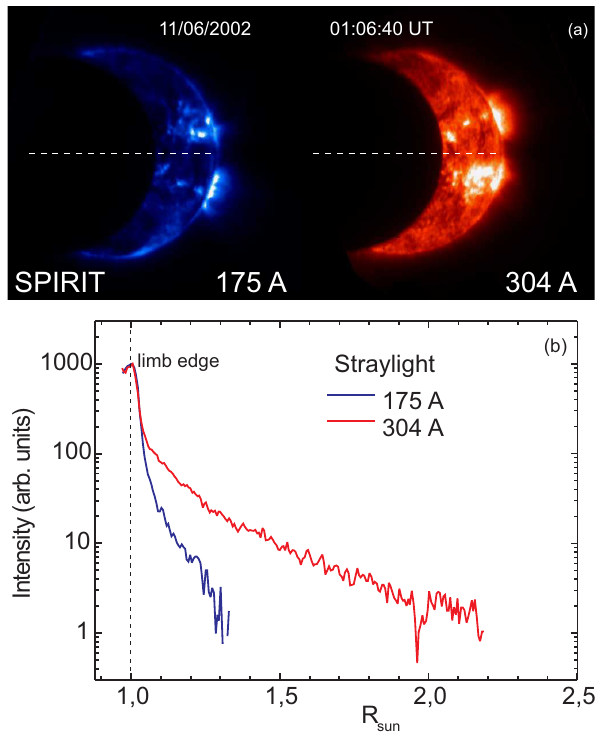
Fig. 3. (a) SPIRIT images in 175 and 304 ˚A obtained during the eclipse of 11 June 2002, 01:06:40UT; (b) radial distributions of the straylight in the SPIRIT 175 and 304 ˚A bands along the scan directions marked by the dashed